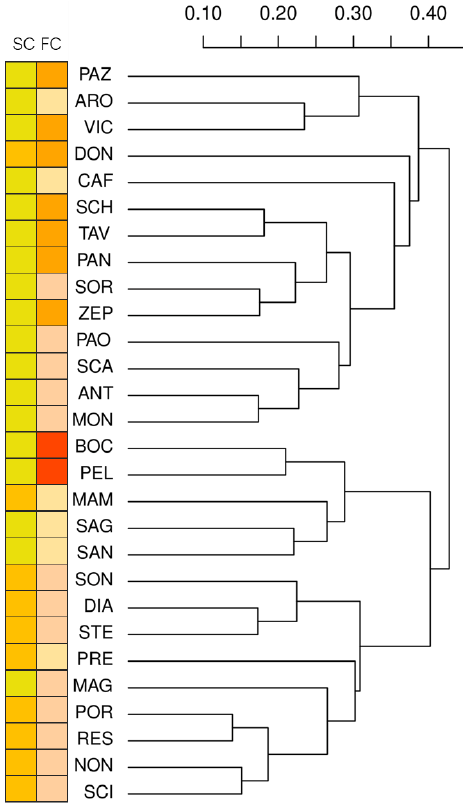
Figure 2. Hierarchical cluster analysis of the 28 apricot landraces based on the 12 scored traits. Distances were computed with the Gower’s coefficient. The coloured squares on the left indicate the ground skin colour (SC) and flesh colour (FC) of the fruits (data are reported in Supplementary Table S1).